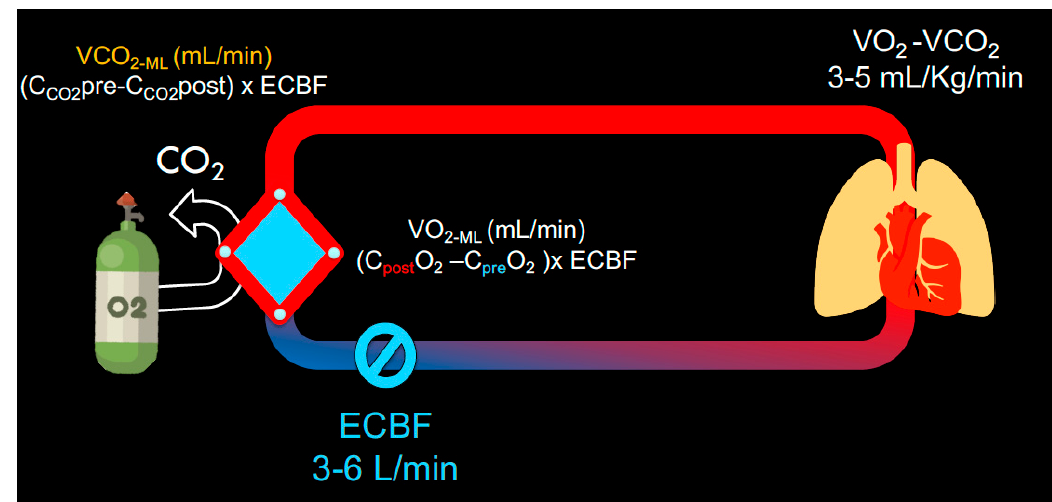
Figure 2. Schematic displays the oxygenation and decarboxylation of venous blood via the membrane lung. The VO 2 and VCO 2 are dependent on the content pre and post membrane and on the extracorporeal blood flow within the ECMO circuit.